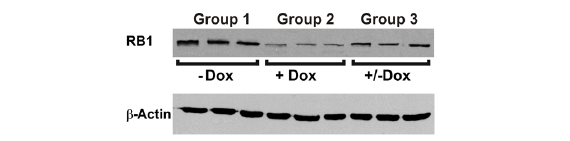
FIGURE 8 | Reversible in vivo DN-CBRb transgene regulation. P10 DN-CBRb + / ROSA-CAG-rtTA + mice were fed with Dox in drinking water for 10 consecutive days. Untreated animals of the same genotype were used as control group (Group 1; − Dox). At the end of Dox treatment animals were euthanized either immediately (Group 2; + Dox) or 5 days after Dox withdraw (Group 3; ± Dox). Supporting the reversibility of the system, RB1 levels were visibly decreased on group 2. Nevertheless, cochleae collected 5 days after Dox withdraw showed RB1 levels, which were comparable to those of the control